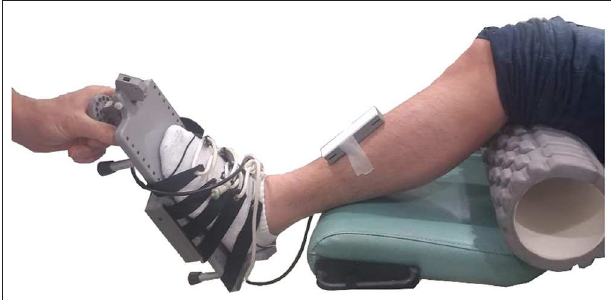
FIGURE 1 | The custom-built electronic goniometer used to measure dorsiflexion range. The participant was placed in a supine position. An 11cm diameter foam roller was placed under the knee. The experimenter rotated the foot through dorsiflexion until 10Nm was reached. Dorsiflexion range was defined as the angle between an accelerometer placed on the tibia and an accelerometer placed underneath the sole of the foot at 10Nm of torque. Ankle angles below 90 ◦ indicate plantarflexion and above 90 ◦